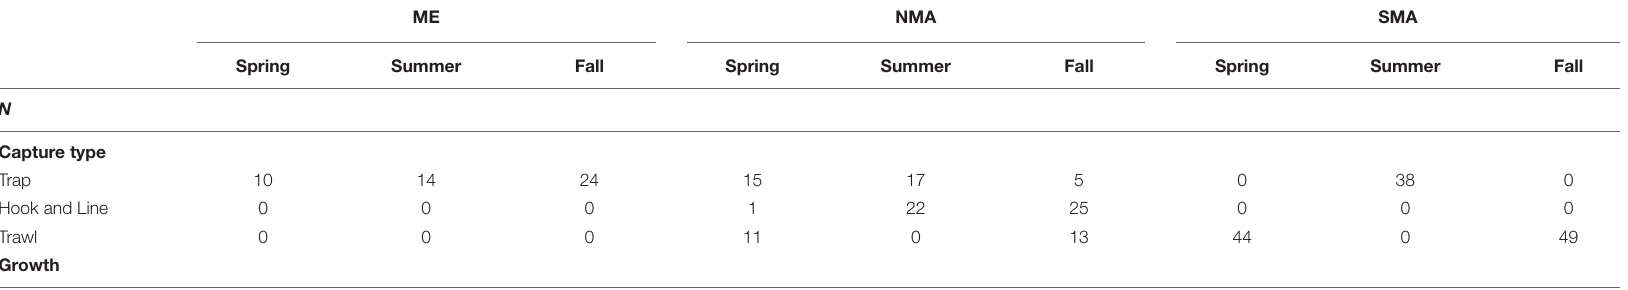
TABLE 1 | Black sea bass sample sizes and life-history parameter estimates by region and